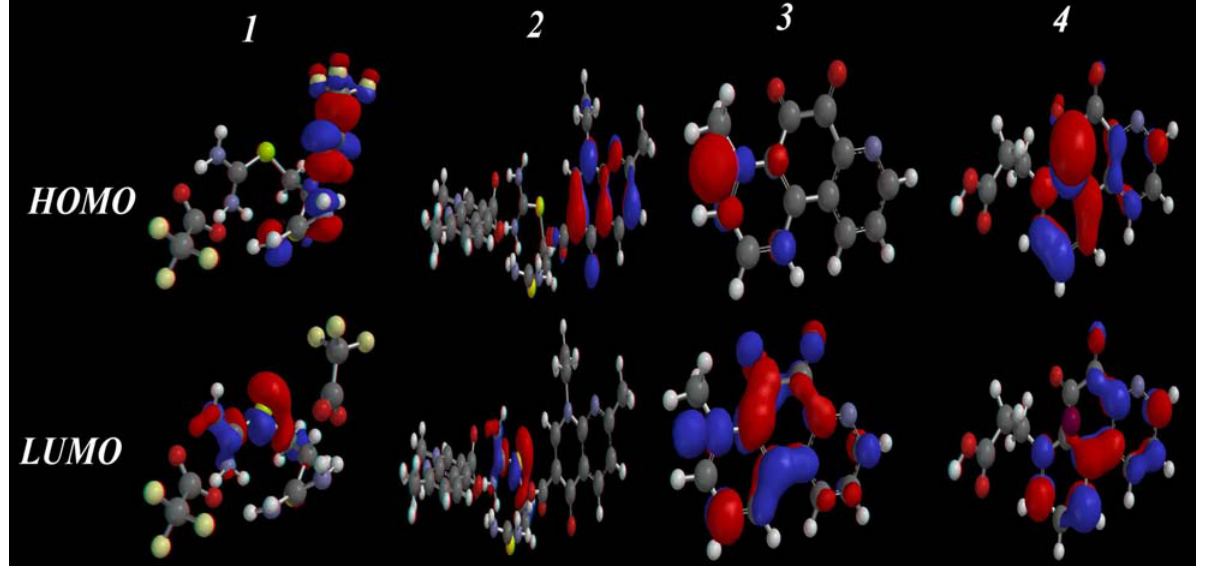
Figure 4. The calculated HOMO, LUMO and HOMO-LUMO gap for 1 – 4 as calculated by the PM3 semiempirical